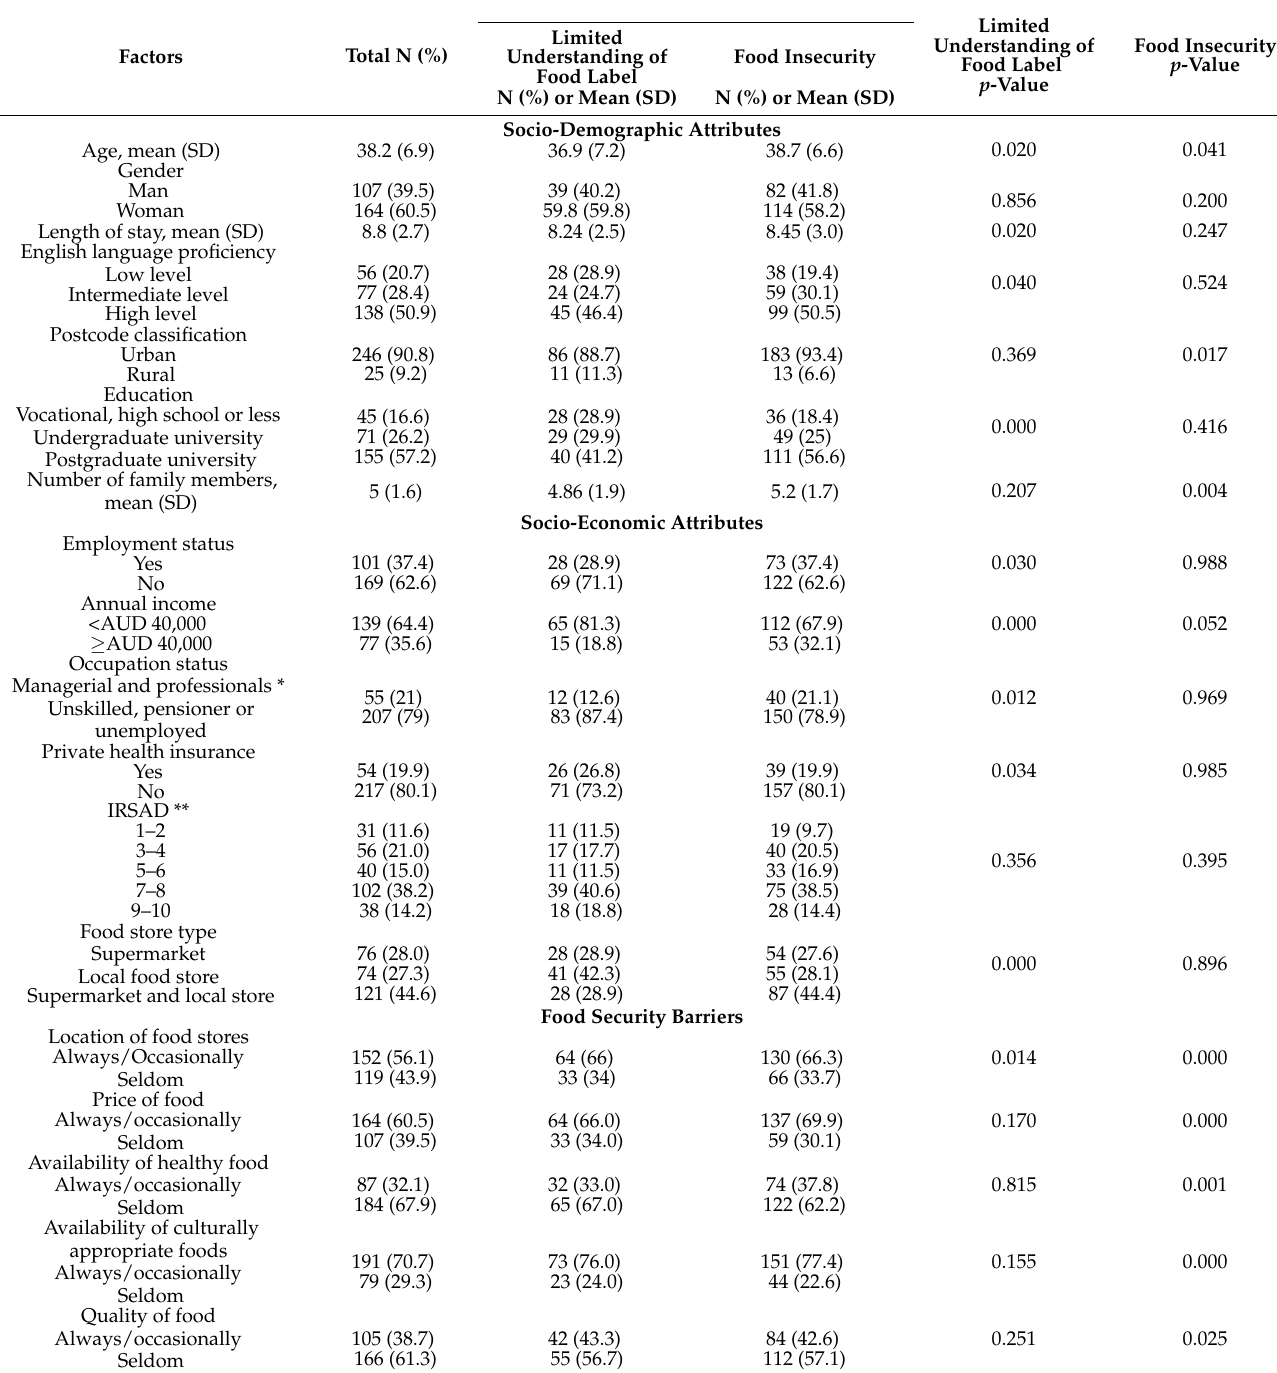
Table 1. Socio-demographic and socio-economic factors of the sample by the level of limited understanding of food labels and the 18-item food insecurity